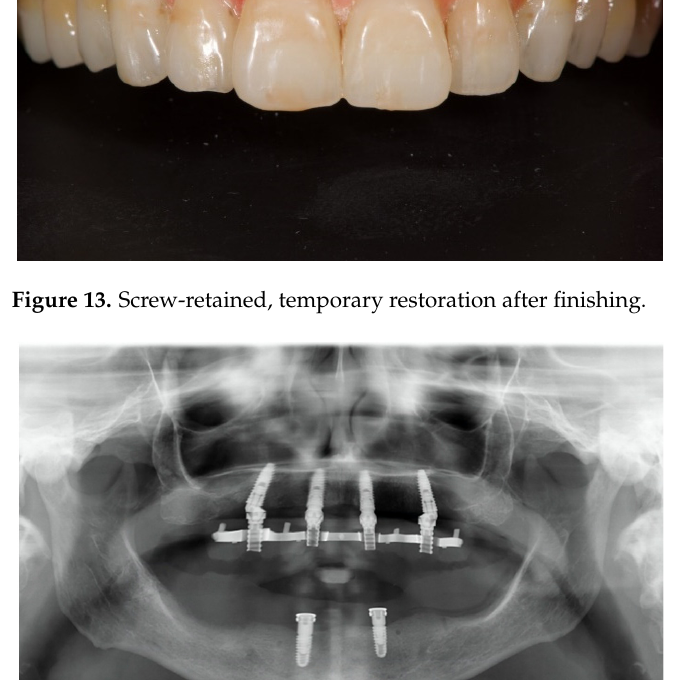
Figure 14. Ortopantomograph taken after implant placement.